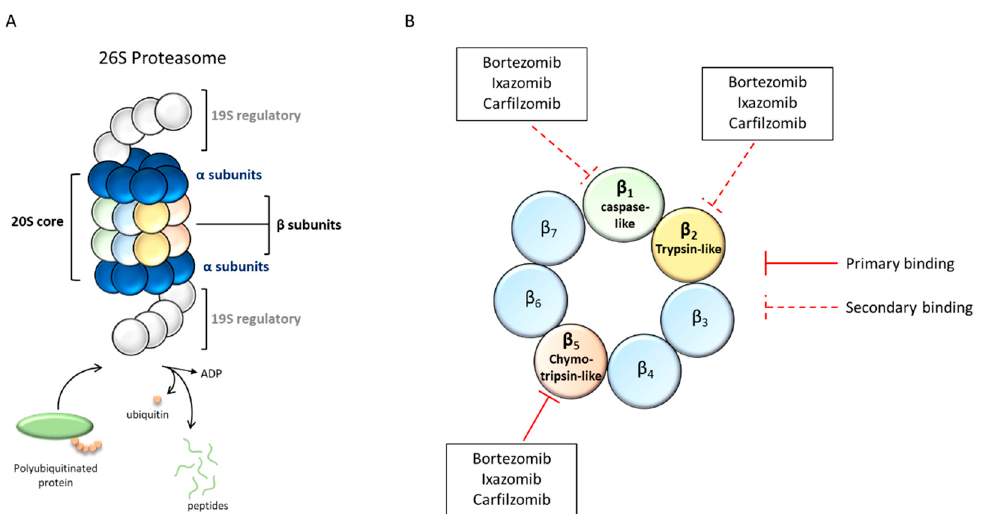
Figure 1. Structure of 26S proteasome and subunit specificities of PIs. ( A ) The 26S proteasome is composed of a core catalytic complex called 20S proteasome and two 19S regulatory complexes, which recognize the ubiquitinated proteins. The 20S region is a cylinder-shaped protease composed of different subunits organized in four rings in a α 7 β 7 β 7 α 7 configuration. The two outer α -rings act as a link for the 19S complexes, whereas the two inner β -rings are responsible for proteolysis. ( B ) Cross-section of β -subunits. Three different catalytic activities, chymotrypsin-like (CT-L), trypsin-like (T-L), and caspase-like (C-L), are located in β 5, β 2, and β 1 subunit, respectively. Bortezomib slowly reversibly inhibits the chymotrypsin-like activity ( β 5 subunit) and, at a higher concentration and in a much less potent manner, also targets the trypsin-like and caspase-like activities ( β 2 and β 1 subunits, respectively). Carfilzomib irreversibly binds mainly the chymotrypsin-like activity, whereas ixazomib reversibly inhibits the chymotrypsin-like activity. Both drugs at very high concentrations interact with the β 2 and β 1 subunits ( B ).